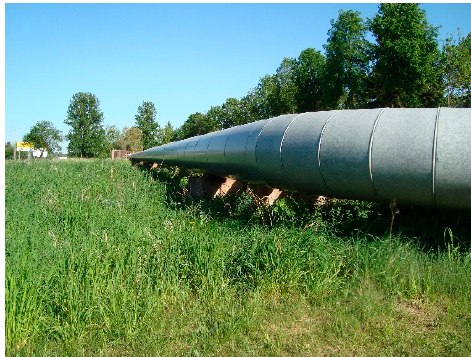
Figure 1. Example of a twin pipe aboveground network located in the city of Bia ł ystok in Poland.